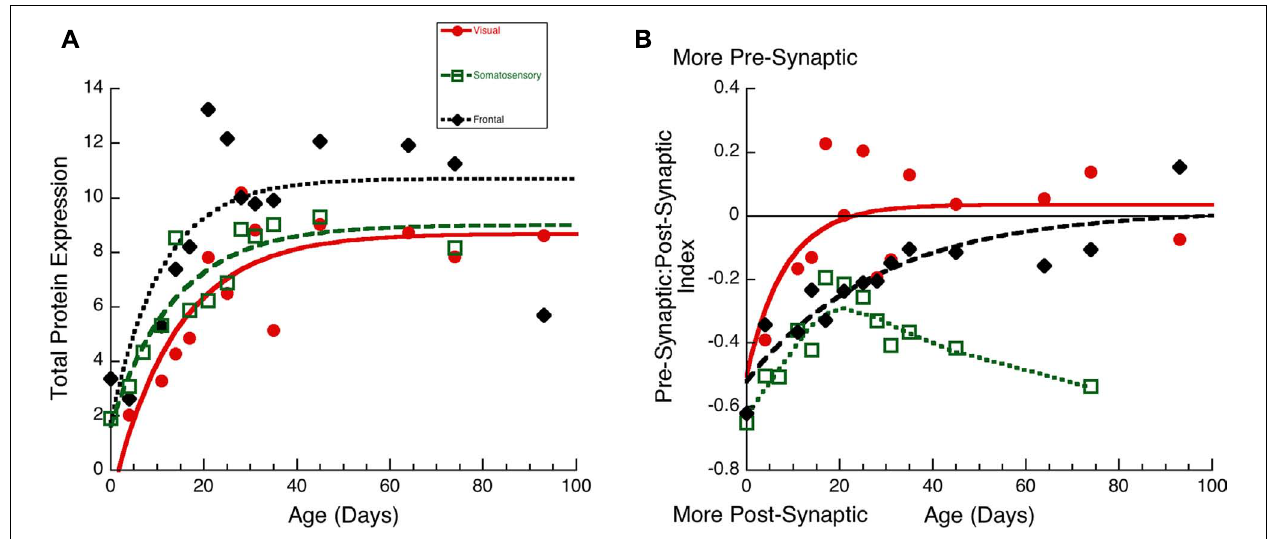
FIGURE 7 | Developmental changes in total protein expression (A) and the pre-synaptic:post-synaptic Index in visual (red dots, solid line), somatosensory (green squares, dashed lines), and frontal (black diamonds, dotted line) cortex. (A) Exponential decay functions were fit to the data for each area, adult levels were defined as 3 τ .Total protein expression reached adult levels in visual at P42 (3 τ = 42.0 ± 17.6; R = 0.84, p < 0.0001), in somatosensory at P42(3 τ = 41.6 ± 13.8; R = 0.92,